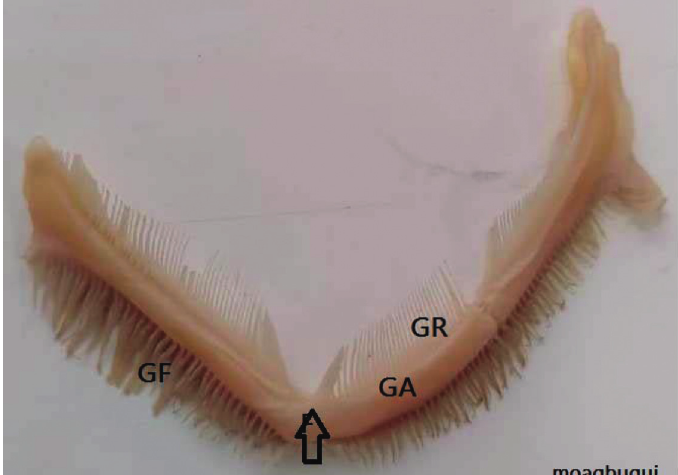
Figure 4: One gill of H. niloticus. GR, gill rakers; GF, gill filament; GA, gill arc. The arrow shows area where the gill folds to extend to the roof of the mouth.